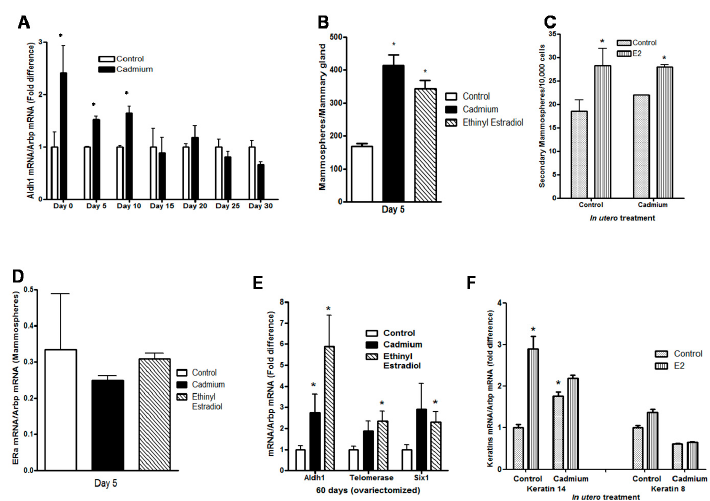
Figure 3. Effects of in utero exposure to cadmium on mammosphere-forming cells in the mammary gland of female offspring. Pregnant female rats were treated with cadmium (5 μ g/kg bw) or